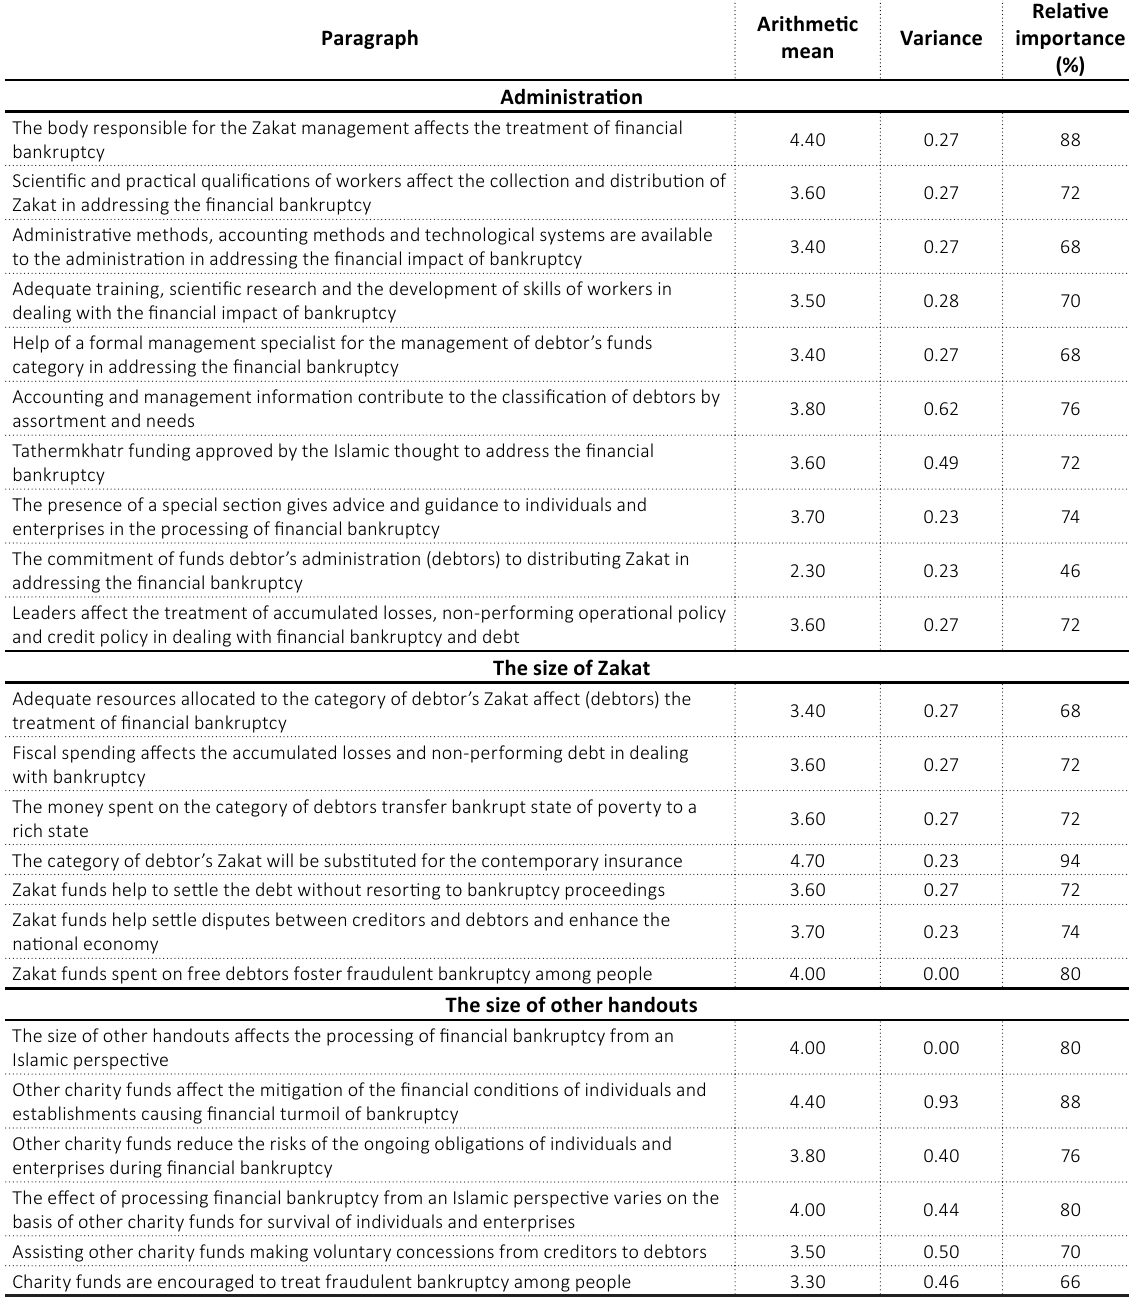
Paragraph Arithmetic